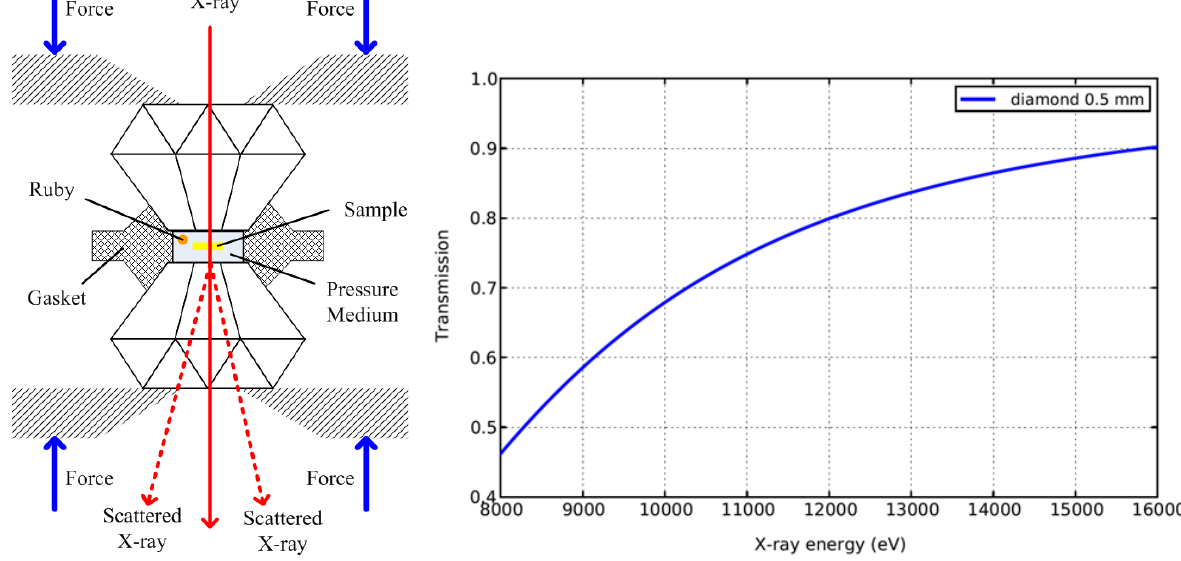
Figure 6: Left: Diamond anvil cell consisting of 2 diamonds. Hydrostatic pressure cells [54, 55]. Right: transmission of diamond of thickness 0.5 mm as a function of the energy in eV of the X-rays (which is inversely proportional to their wavelength)